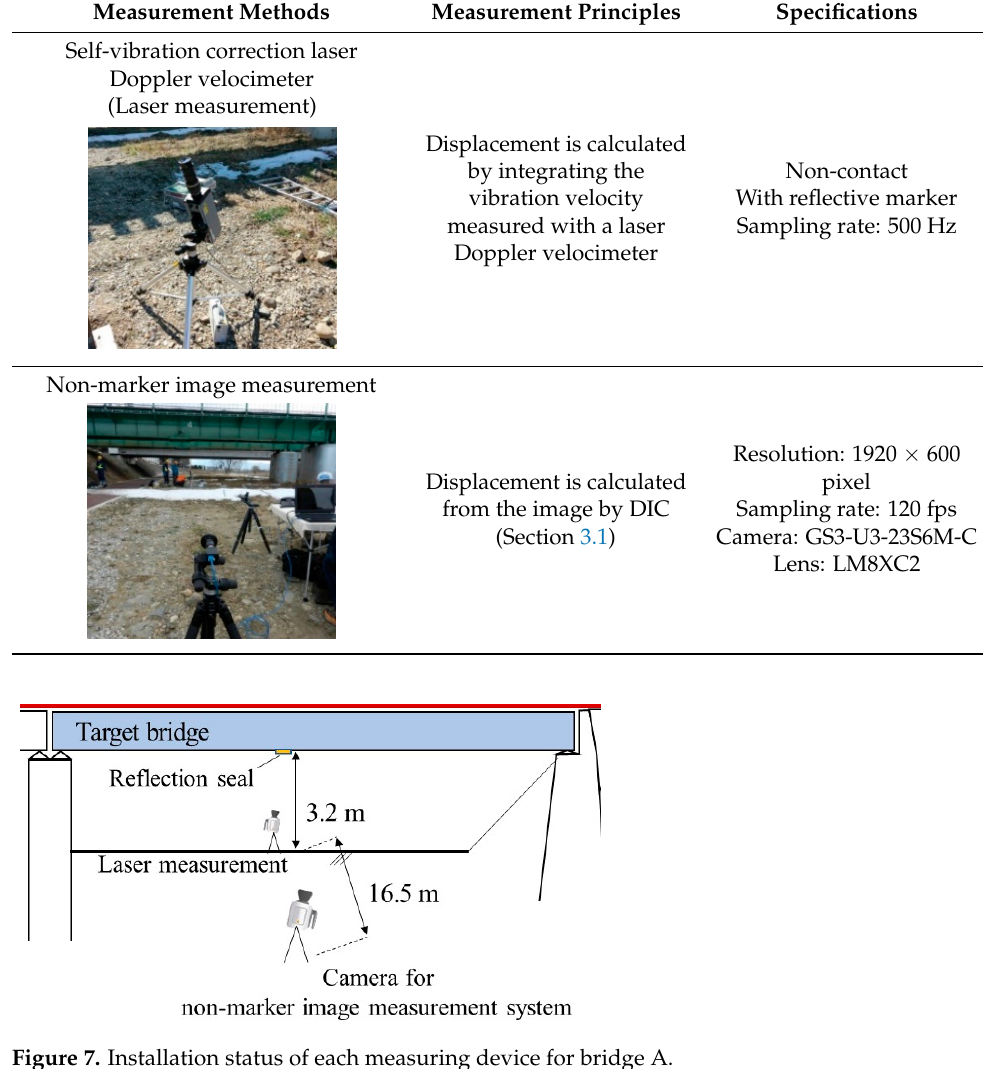
Table 5. Specifications of the measuring equipment on bridge A.